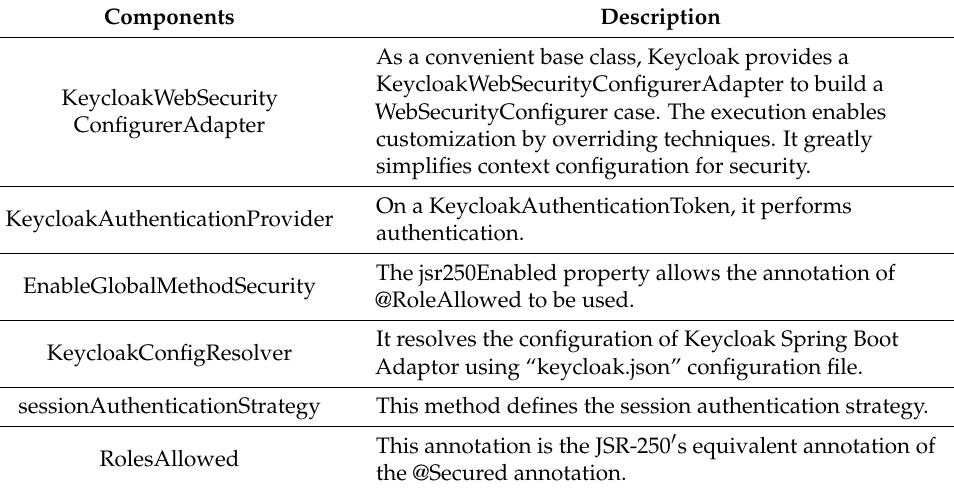
Table 2. Selected list of Keycloak components for spring security framework integration.